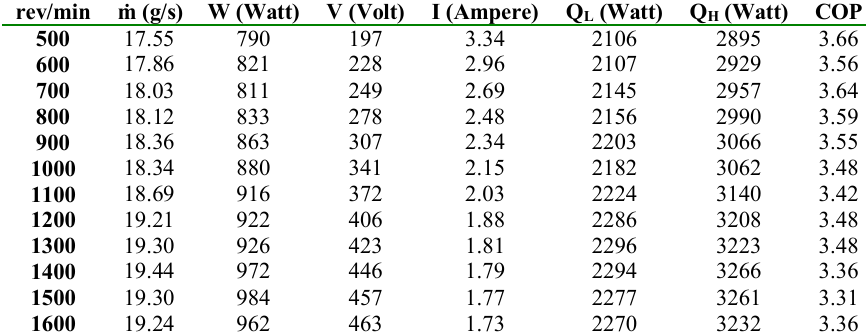
Table 2. Air conditioner indicator values for heating process